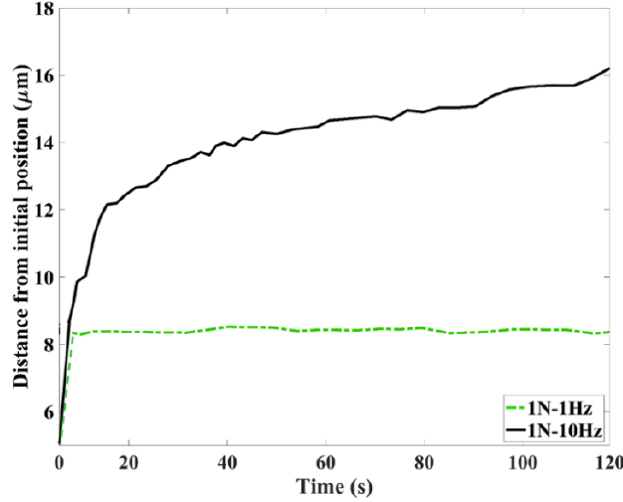
Figure 11. Effect of frequency on wear. Figure 11. E ff ect of frequency on